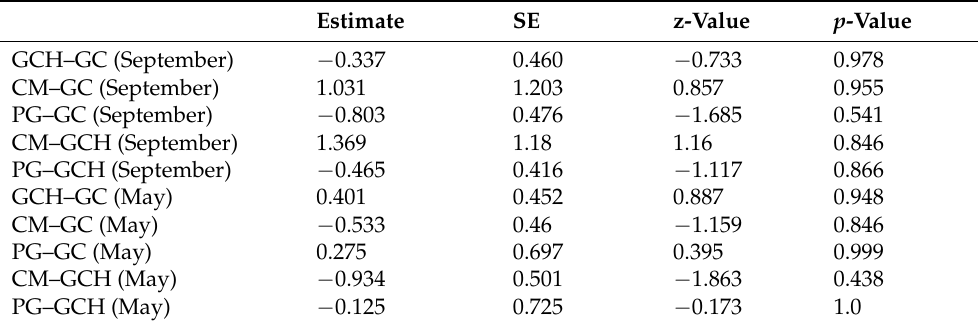
Table A15. Differences in the Chao diversity index of carabid beetles, comparing grass–clover (GC) and grass–clover herbs (GCH) with each other, and in comparison to conventional maize (CM) and permanent grasslands (PG) in May/June and September.